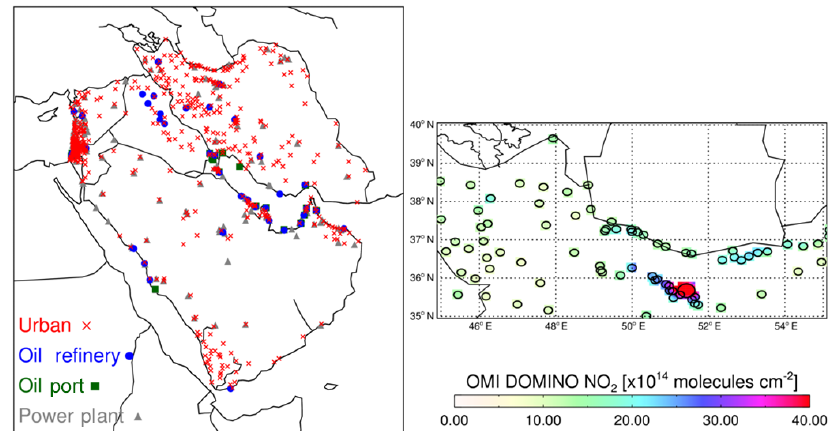
Figure 2. (Left) The geographical distributions of the target locations showing cities and towns (in red) as specified by the GRUMP v1 settlement point data base (Balk et al., 2006; SEDAC, 2015), oil refineries (in blue) (based on Kootungal, 2010), and oil ports and power plants based on the Global Energy Observatory (GEO) online resource (http://globalenergyobservatory.org). (Right) OMI 2005 NO 2 annual mean of over northern Iran, with a spatial filtering mask applied to extract observations over urban centres (see Sect. 3.2). The OMI data have been averaged onto a 0.05 ◦ × 0.05 ◦ grid using observations with cloud fractions < 20% and solar zenith angles ≤ 70 ◦ . Observations affected by the row anomaly are excluded, as described in Sect. 3.1, and have been smoothed with a 0.15 ◦ × 0.15 ◦ Gaussian filter of 1 σ